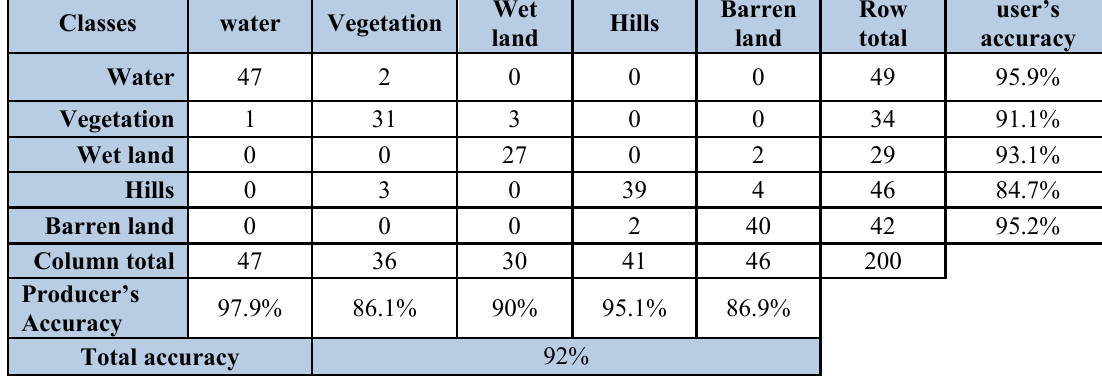
Table 5: Error matrix with producers, users, and overall accuracy calculations for unsupervised classification using mean value for Landsat-5 (1990).